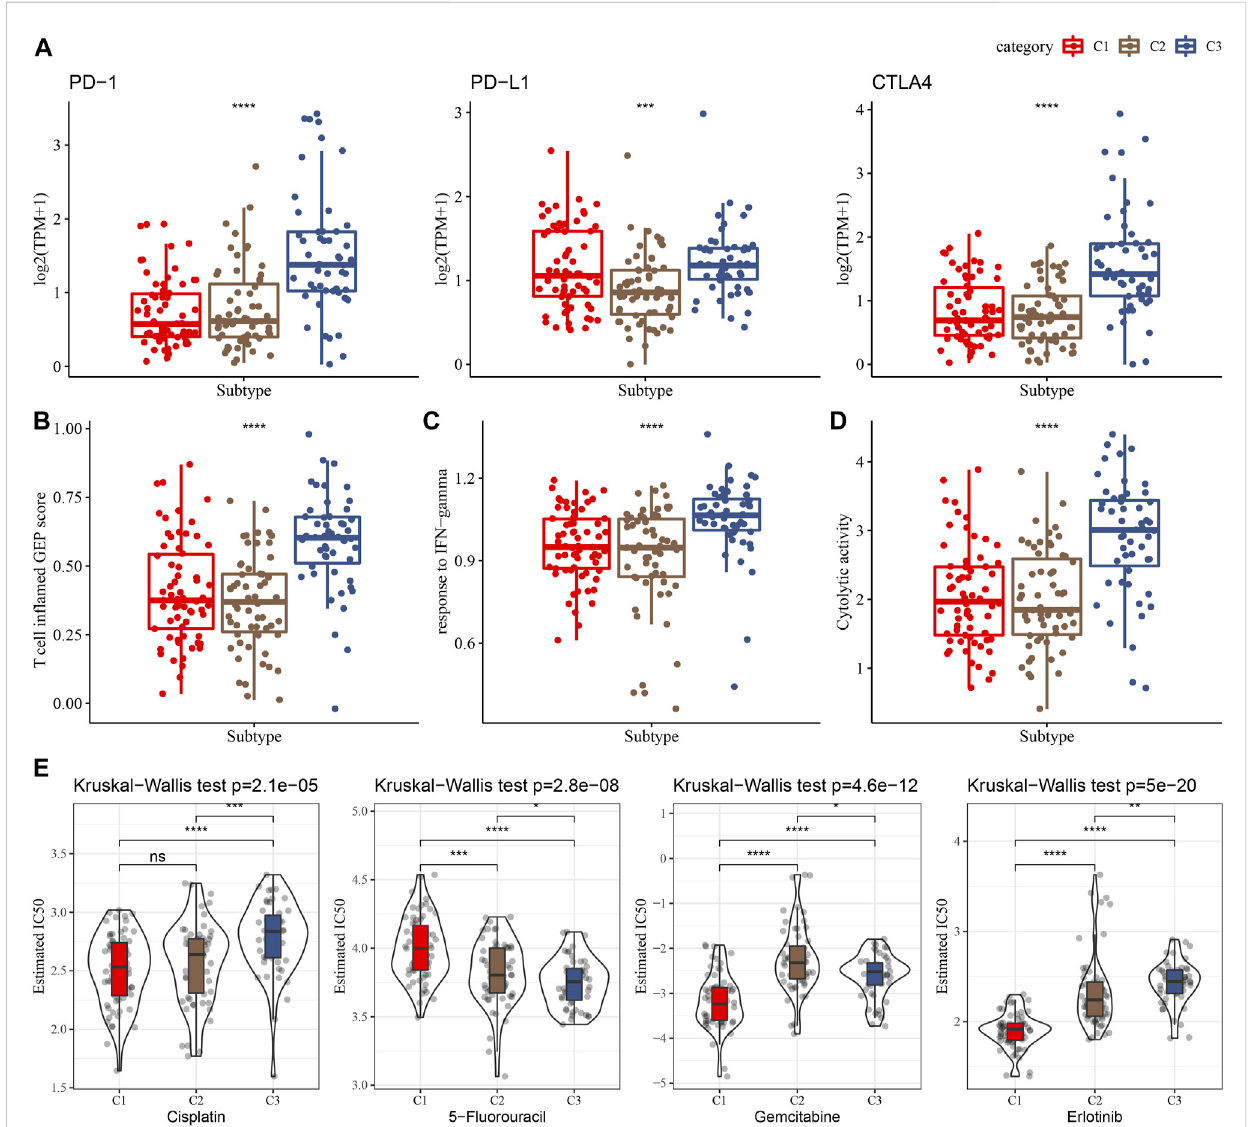
FIGURE 5 Differences in the immunotherapy response and drug sensitivity among clusters in the TCGA cohort. (A) Comparison of the ICGs among clusters. (B – D) Showing comparisons of the T cell in fl amed GEP score, response to IFN- γ , and Cytolytic activity among clusters, respectively. (E) The box plots of the estimated IC 50 for cisplatin, 5-Fluorouracil, gemcitabine and erlotinib in the three